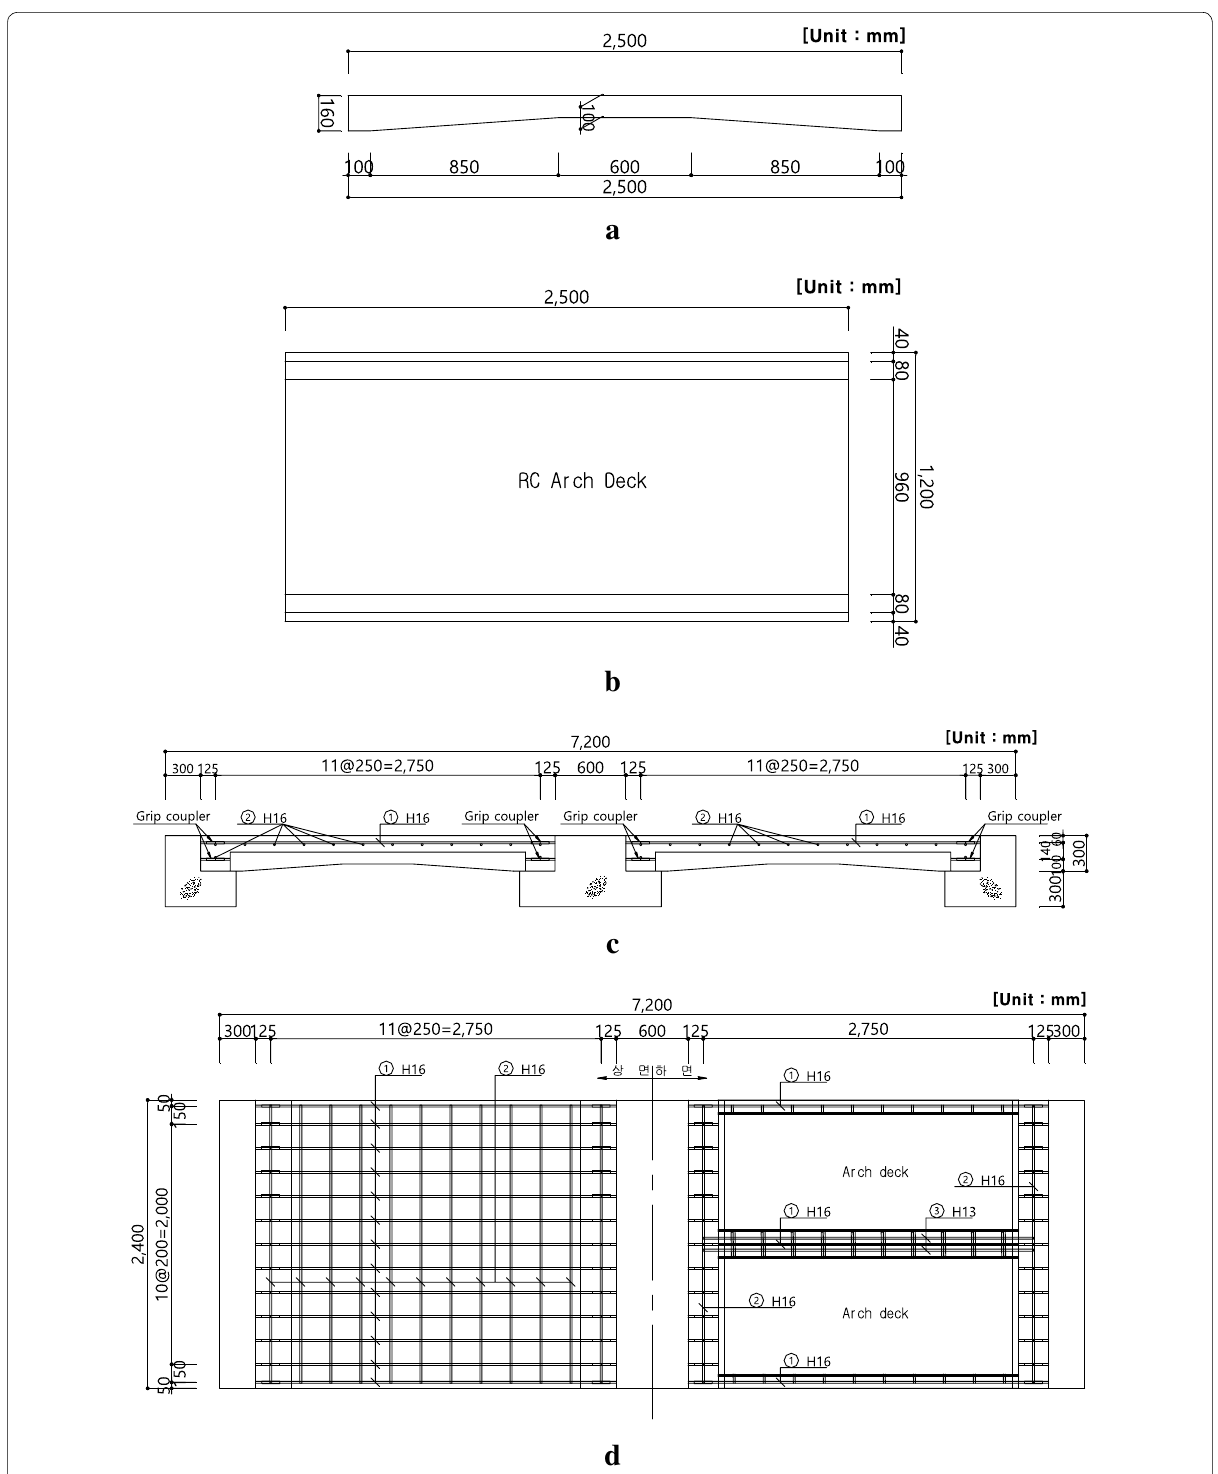
Fig. 1 RC arch deck (AD) and 2‑span RC arch deck specimen (BD) layout. a Front view of RC arch deck (AD). b Top view of RC arch deck (AD). c Front view of 2‑span RC arch deck specimen (BD). d Top view of 2‑span RC arch deck specimen